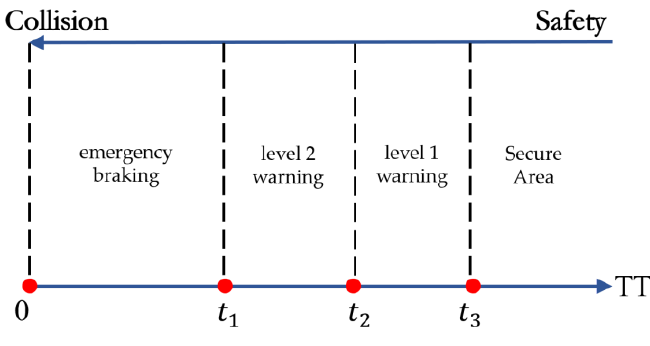
Figure 12. Vehicle safety status division.